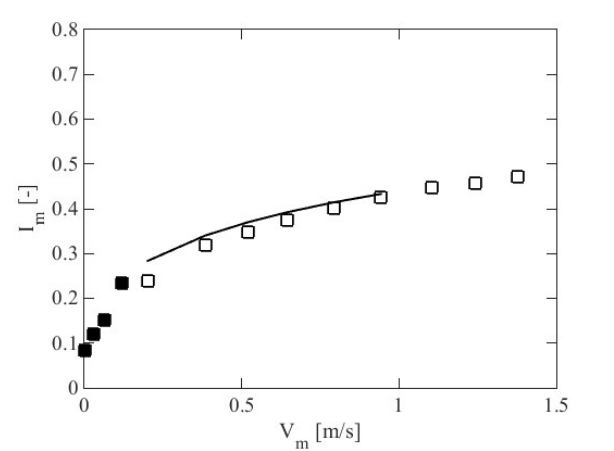
Fig. 6 . Figure of hydraulic gradient predictions for run no. 8. Legend: filled squares – measured point in stationary bed, squares – measured points in sliding bed, continuous line – prediction .